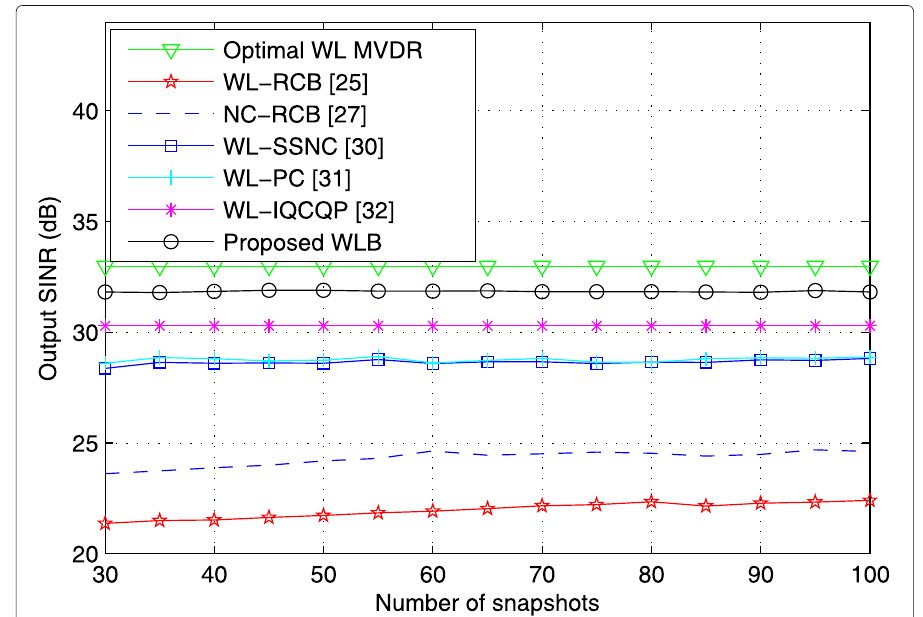
Fig. 3 Example 1. Output SINR of all WLBs versus the number of snapshots